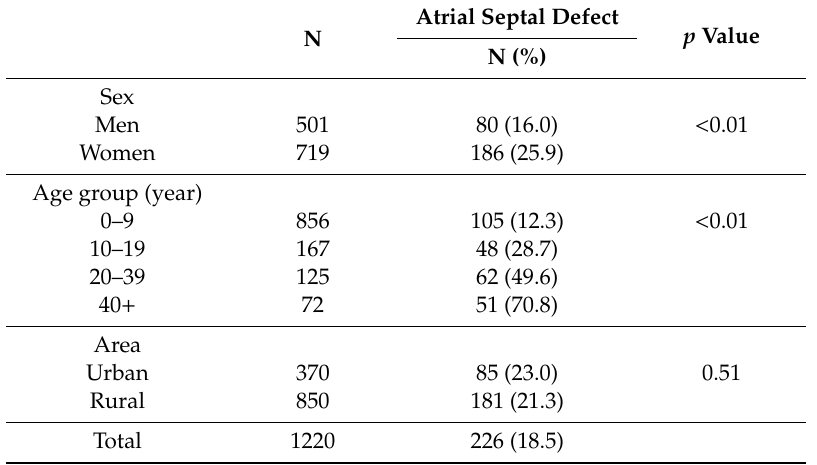
Table 2. Prevalence of atrial septal defect among congenital heart disease patients, 2010–2015. N